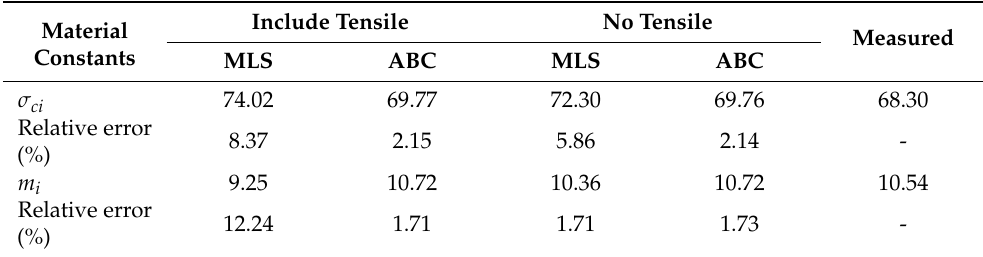
Figure 7. The Hoek-Brown failure envelope determined using different methods: ( a ) tensile; ( b ) no tensile. Table 1. The obtained strengths using different methods.